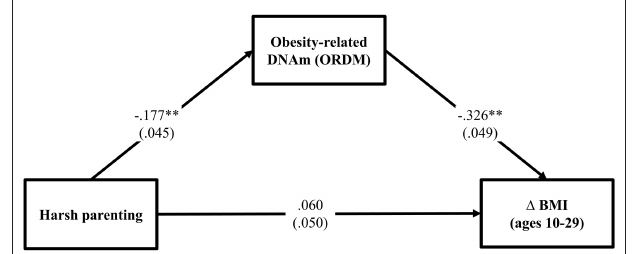
FIGURE 2 | Methylation of obesity-related genes mediates the impact of harsh parenting on change in body mass index ( N = 362). Chi-square = 0.512, df = 2, p = 0.774; CFI = 1.000; RMSEA = 0.000. Values are standardized parameter estimates and standard errors are in parentheses. Genetic risk score for obesity, males, income, exercise, unhealthy diet are controlled in these analyses. 1 = change in BMI from ages 10 (wave 1) to 29 (wave 7). ** p ≤ 0.01; * p ≤ 0.05 (two-tailed tests).